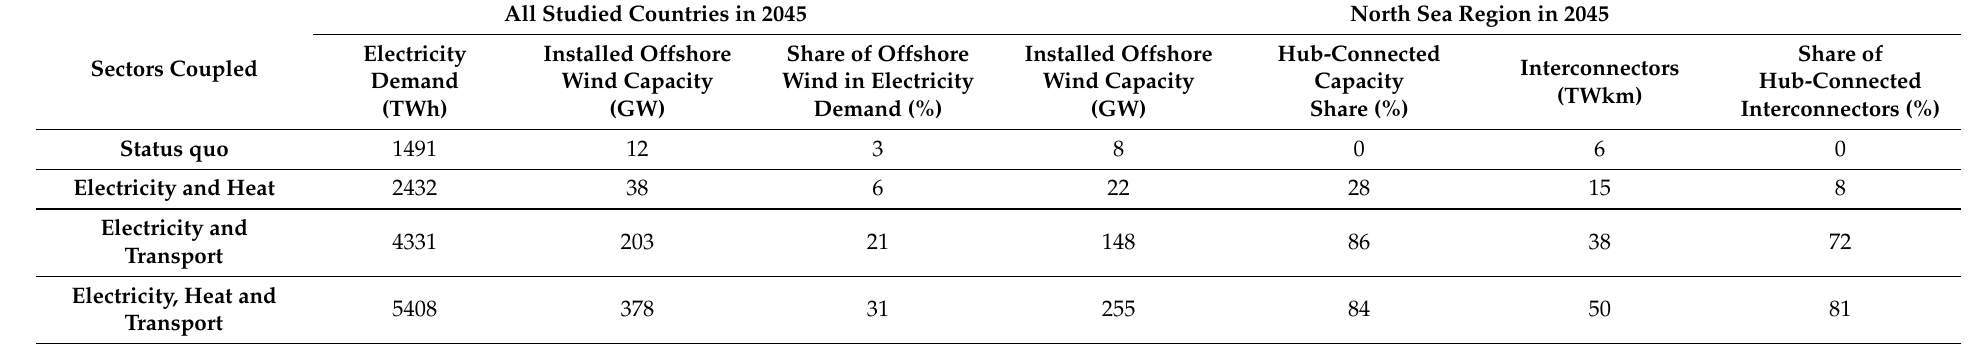
Table 4. Summary of key results under different levels of sector coupling.